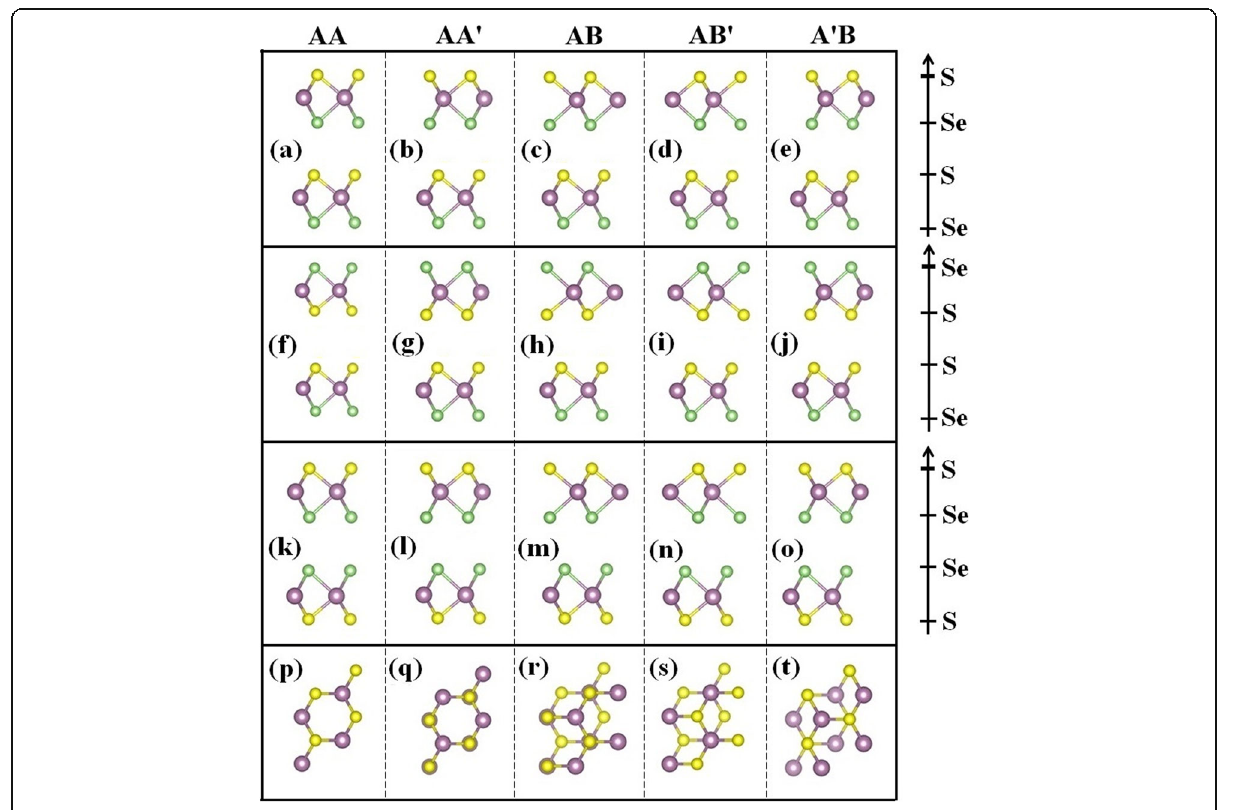
Fig. 1 Top and side views of the atomic configuration of WSSe bilayer. The purple balls represent the W atoms, and the yellow and green balls represent the S and Se atoms,